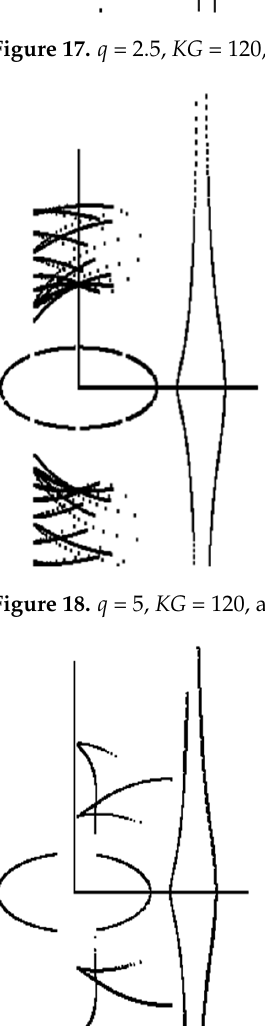
Figure 19. q = - 1, KG = 100, and DK = 100. Figure 19. q = − 1, KG = 100, and DK =